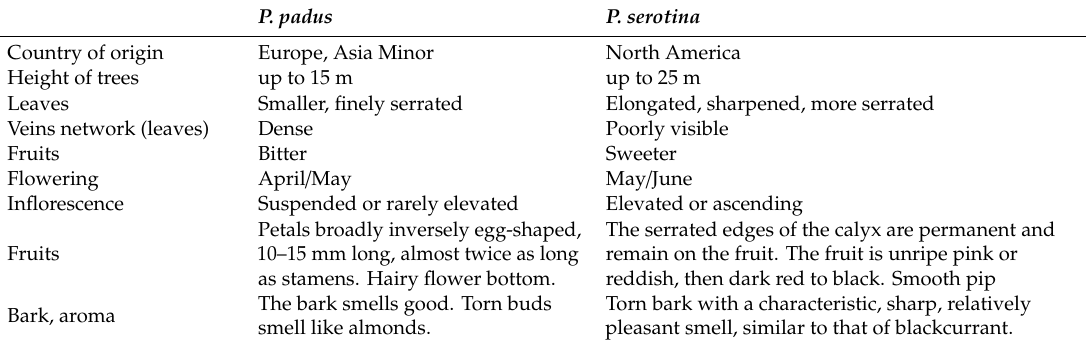
Table 2. Comparison of botanical characteristics of P. padus and P. serotina